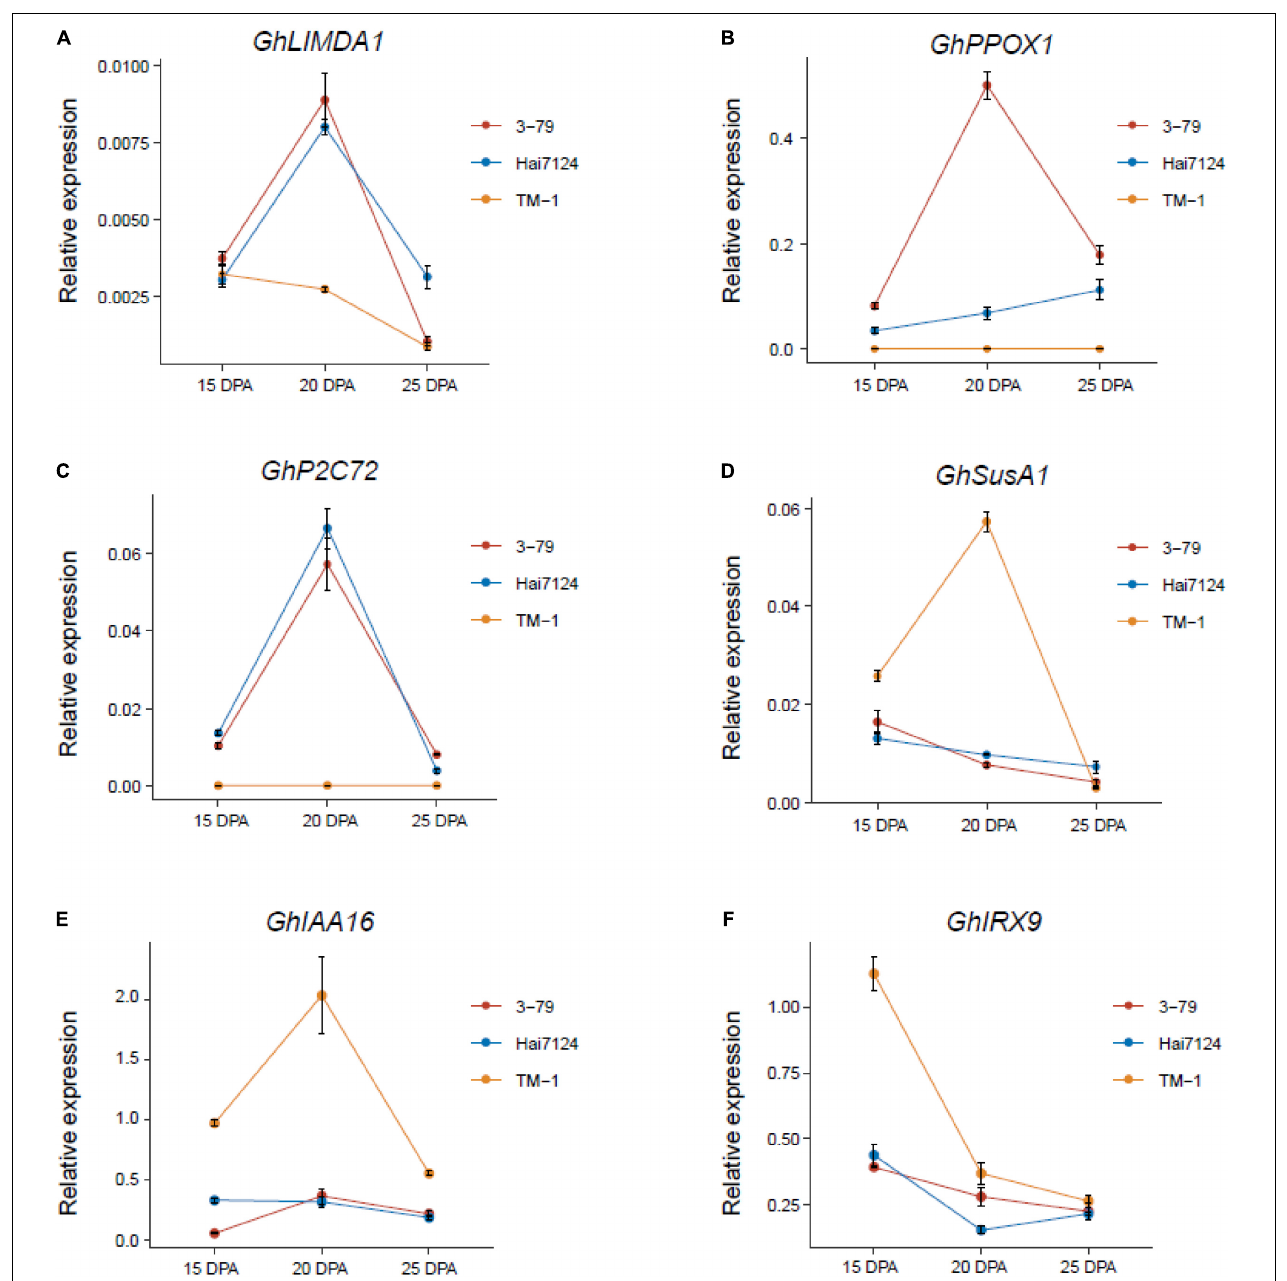
FIGURE 5 | Validation of the candidate genes with qRT-PCR. (A–F) The expression levels of six candidate genes in 15, 20, and 25 DPA fibers of TM-1, Hai7124, and 3-79 were performed with qRT-PCR. Each point of the line chart shows the average value of three repeats, and each error bar represents one standard